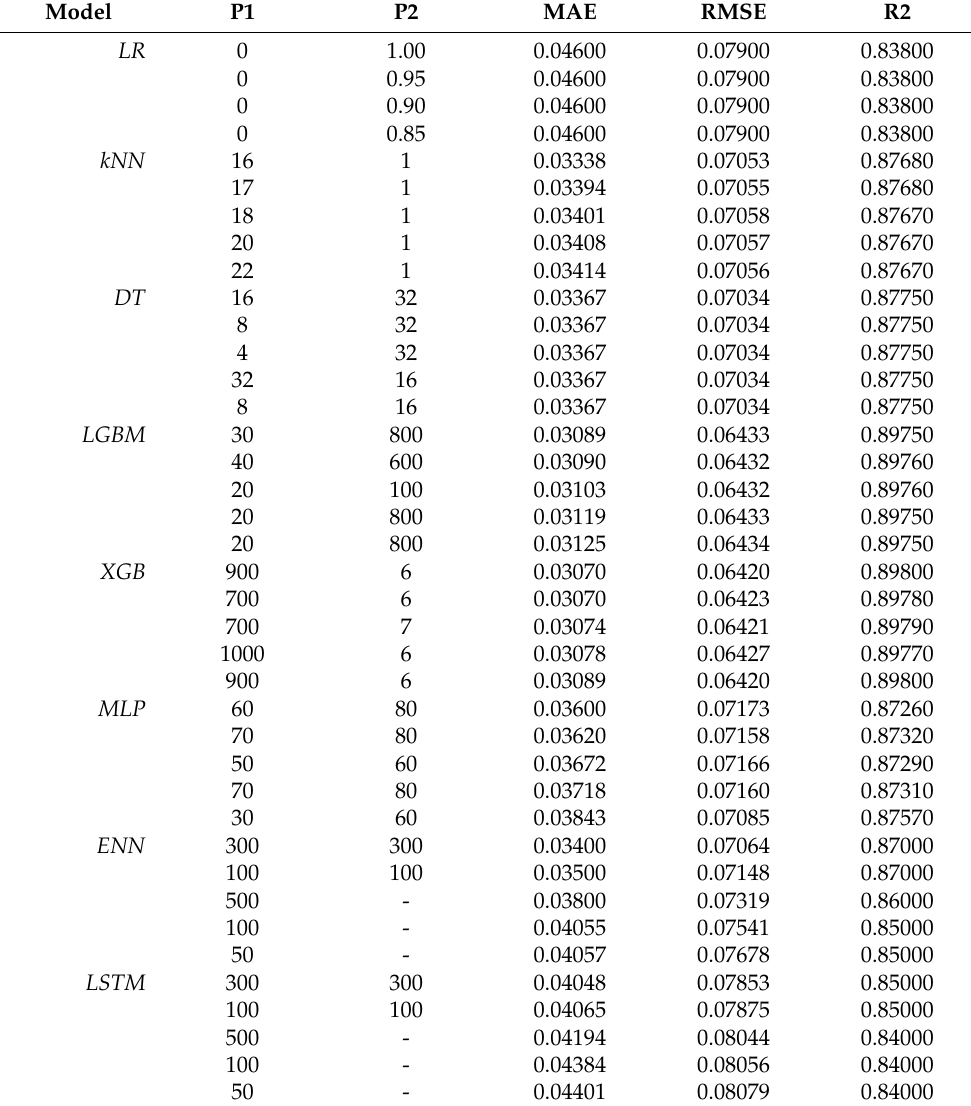
Table 3. Grid search results. Best results obtained and the combination of the paired parameters P1 and P2 for each model. Each hyperparameter stands for a particular feature of the model in question. All rows of the same model are sorted by